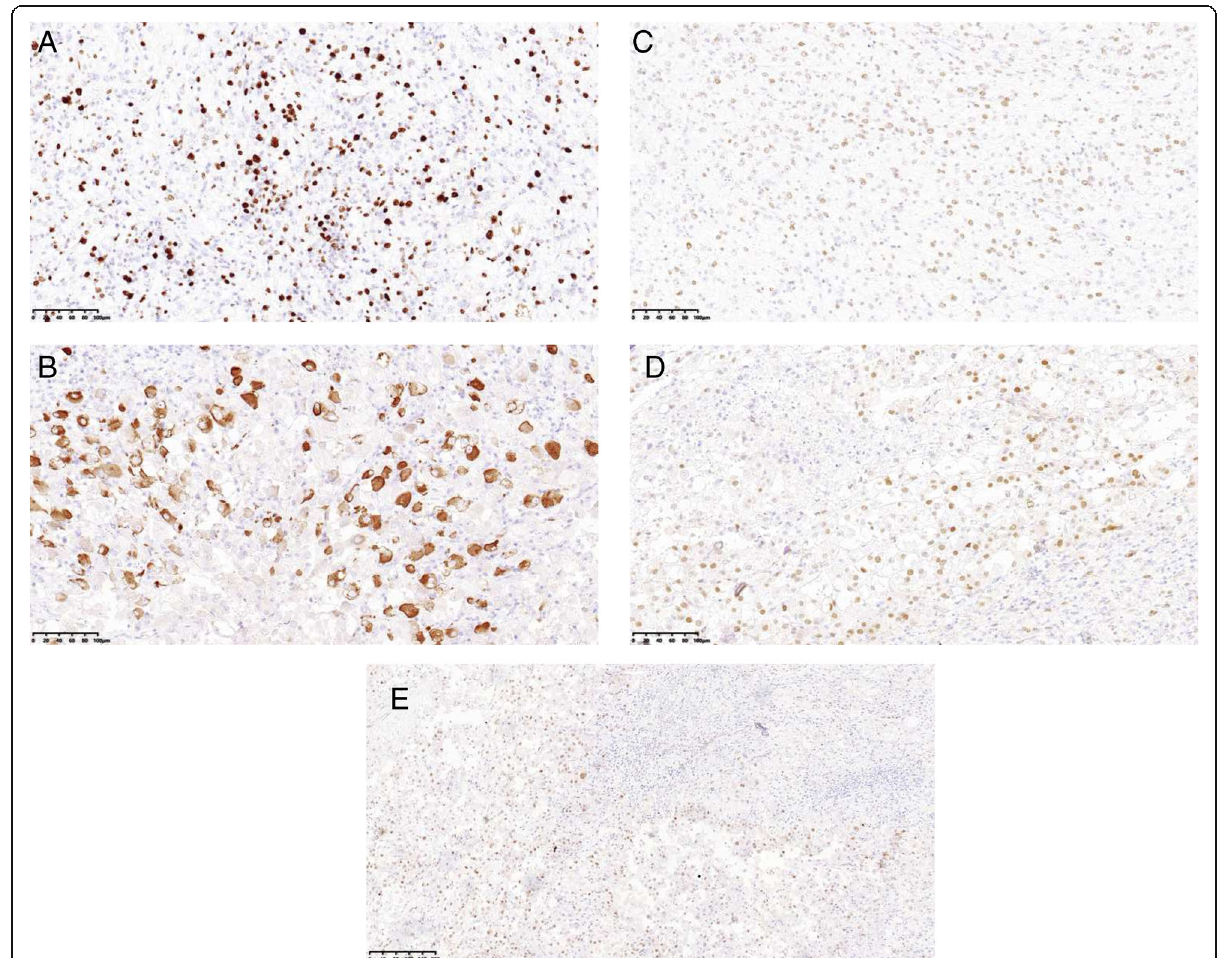
Table 2 Parathyroid carcinoma with sarcomatoid differentiation reported in the literature Authors Sex Age Maximum Blood Blood PTH Positive Immunopheno type Prognosis (yr) diameter mass calcium (cm) Taggart et al. F 57 4 Normal Normal CGA and vimentin were positive Lung metastasis Nacamuli et al. M 54 9 Elevated Elevated AE-1, PTH, CGA, Syn, and desmin were positive Zhang Haitao et al. Guan Zhongyan et al. F